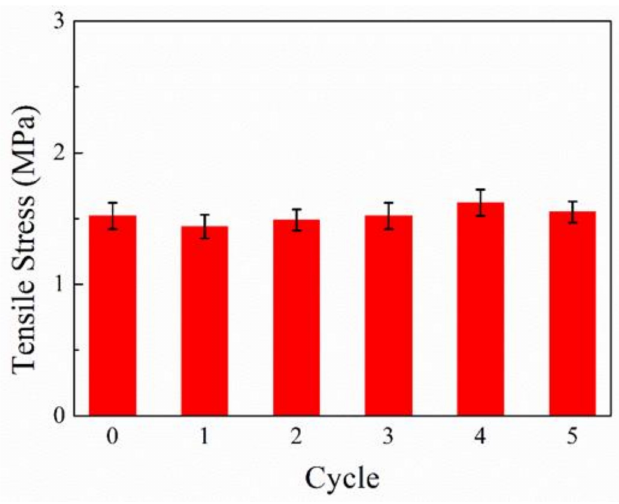
Figure 13. The tensile strength of the C-EC / TPU changes under di ff erent cycle test times.